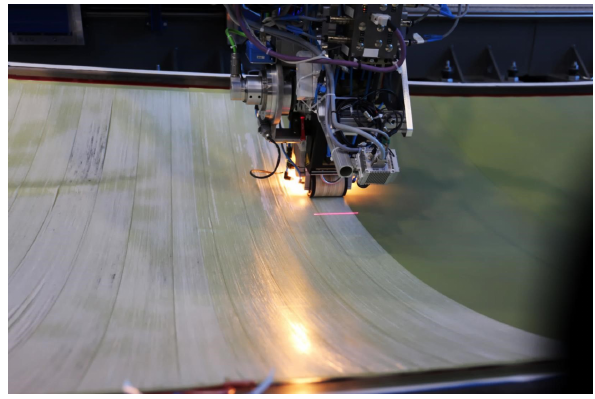
Figure 4: Laser light section sensor mounted to an automated fiber placement head, © DLR